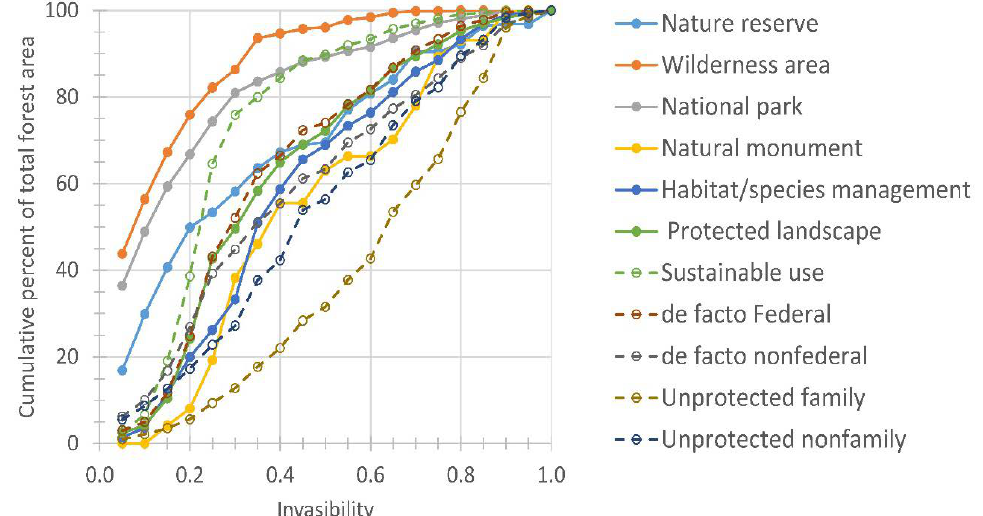
Figure 2. Estimated cumulative invasibility by protection category. Each point indicates the percentage of total forest area with invasibility less than or equal to the indicated value. Note: “unprotected family” is private, family-owned, no IUCN designation; “unprotected nonfamily” is private, not family-owned, no IUCN designation.